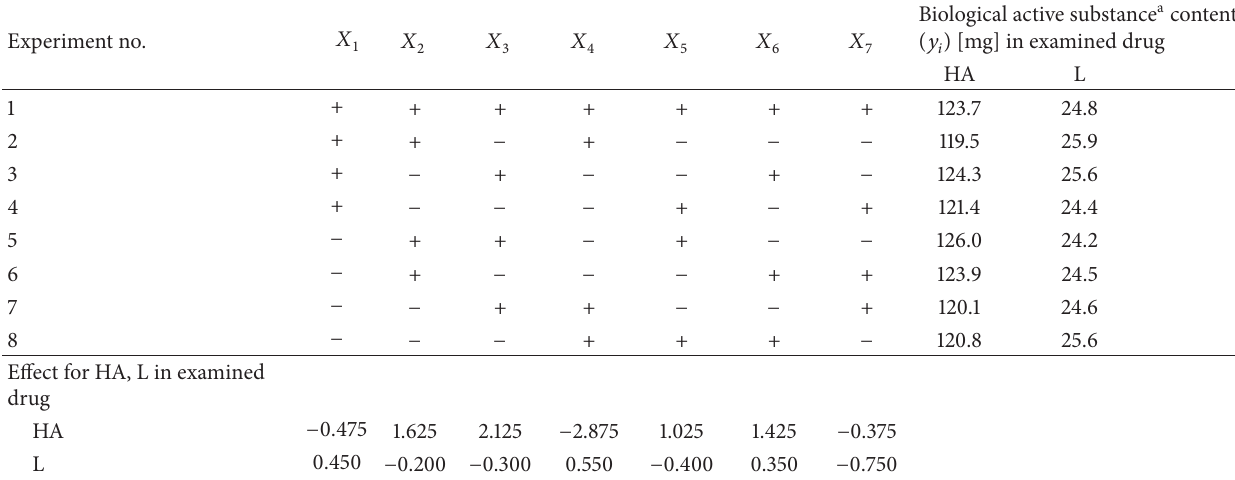
Table 1: Experimental design matrix (2 3 ) for robustness test for biological active substances coming from injection dosage form of examined